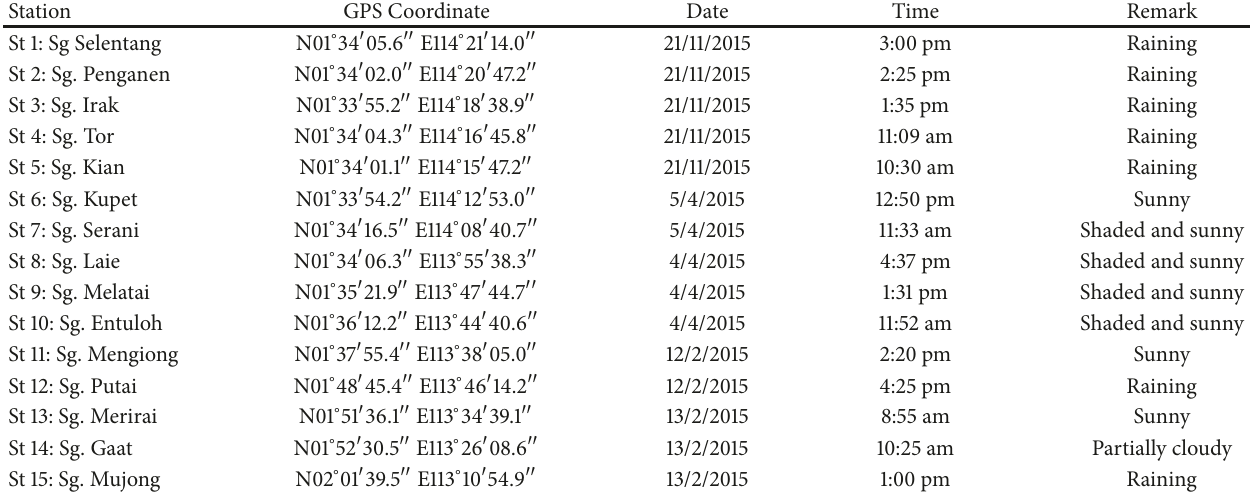
Table 1: The details of the sampling regime and sampling location in the present